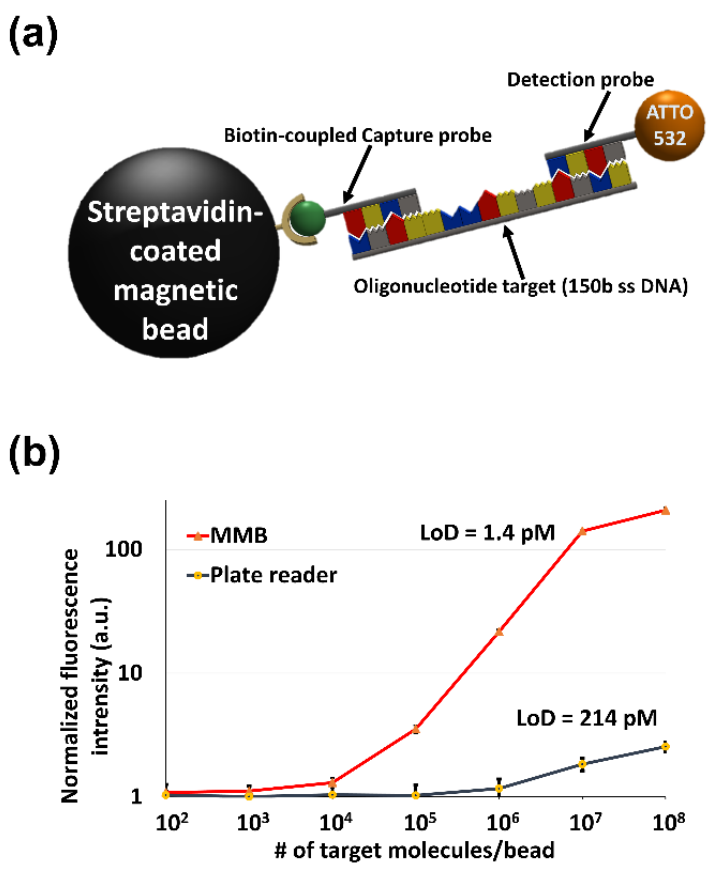
Figure 10. ( a ) Schematic of the sandwich hybridization assay (SHA). Capture and detection probes are hybridized to the target oligonucleotide and captured by streptavidin-coated magnetic beads. ( b ) Results of an SHA dose-response experiment performed with the MMB device (solid red line) and with a conventional fluorescence plate reader (solid black line). MMB achieves 150 times higher sensitivity than the plate reader. Reprinted from [18], Copyright © 2019 John Wiley &